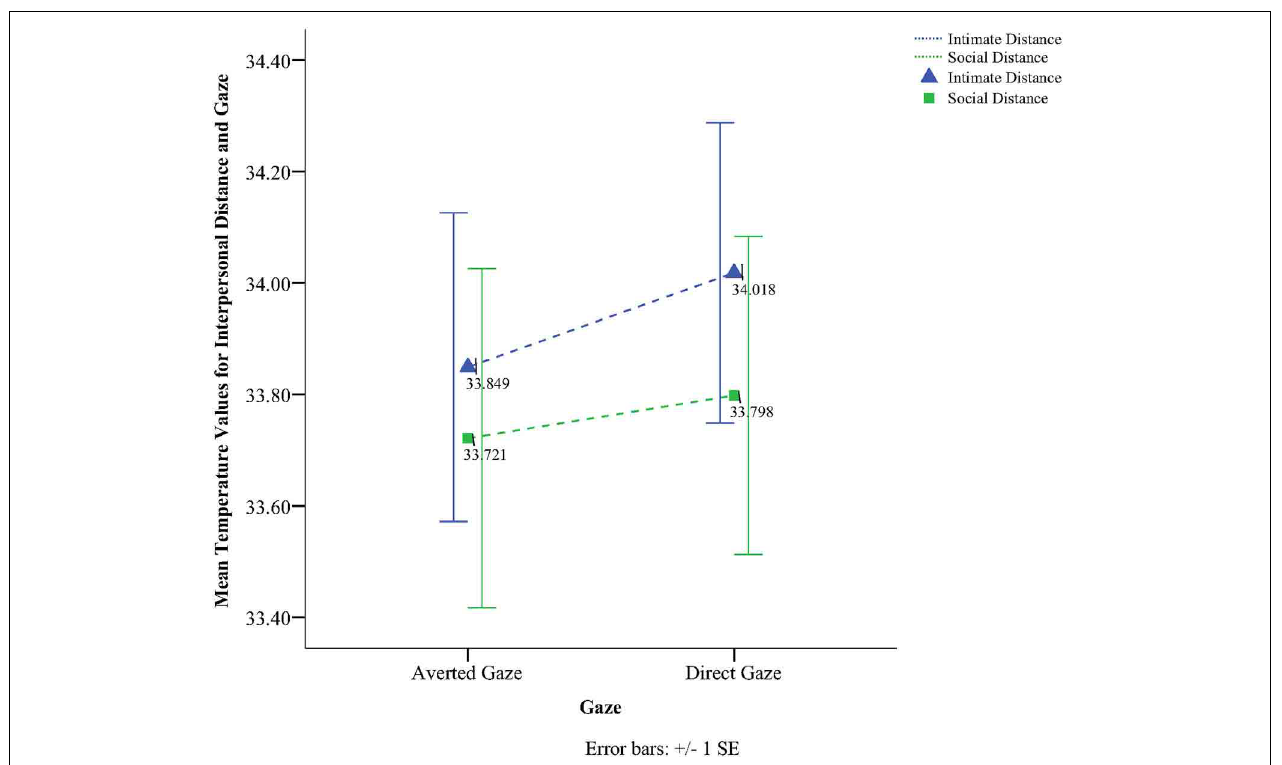
FIGURE 3 | Line graph representing the interaction effect between interpersonal distance and gaze.